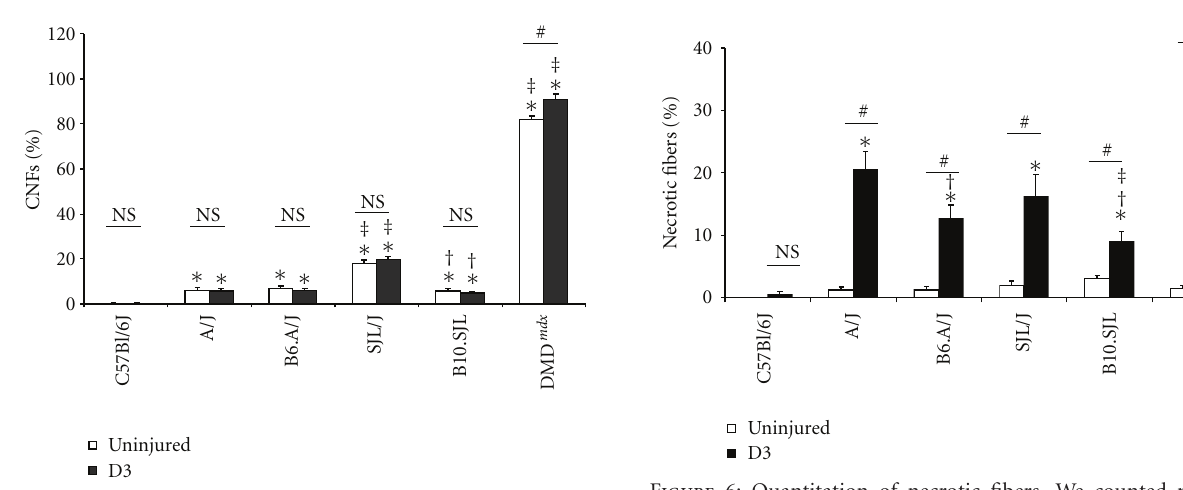
Figure 5: Quantitation of CNFs. We counted CNFs in H&E-stained cross sections of uninjured and injured TA muscles. In uninjured muscles, CNFs were elevated in all dysferlin mutants, with SJL/J muscle showing the greatest elevation. DMD mdx muscle showed several-fold CNFs more than all the dysferlinopathic samples. Except for DMD mdx , none of the strains showed changes in CNFs at D3. ∗ Significant di ff erence compared to control strain at same time point. # Significant di ff erence within same strain between uninjured and D3. † Significant di ff erence compared to same Dysf mutation at same time point. ‡ Significant di ff erence compared to A/J at same time point. NS:no significant di ff erence.